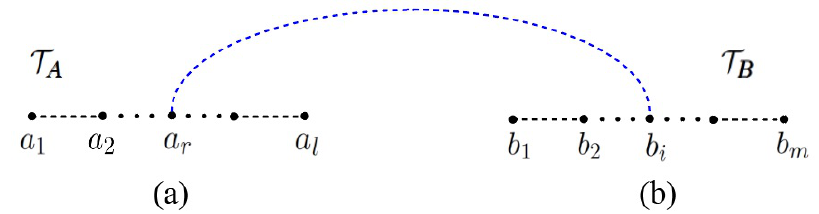
Figure 4 . In this graph, T AAA and T BBB are both simple chains. The permutations for given choice of a r and b i in the graph-based BCJ relation can be conveniently determined by connecting a r and b i via a line, and the node b is always regardered as the leftmost 1